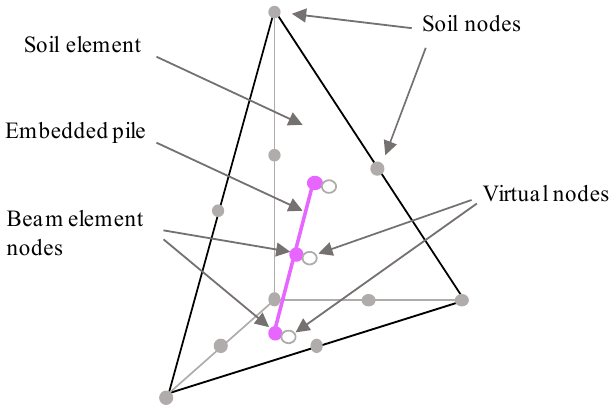
Figure 1. Embedded pile within a 10-node tetrahedral element.